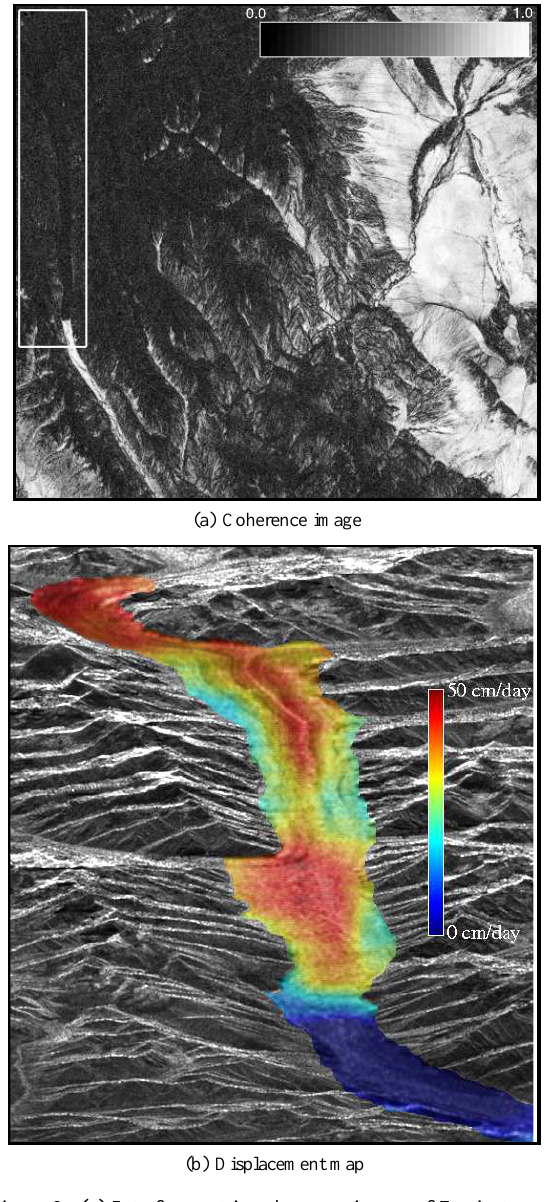
Figure 3: (a) Interferometric coherence image of Envisat scene. The white rectangle indicates the location of Inyltshik